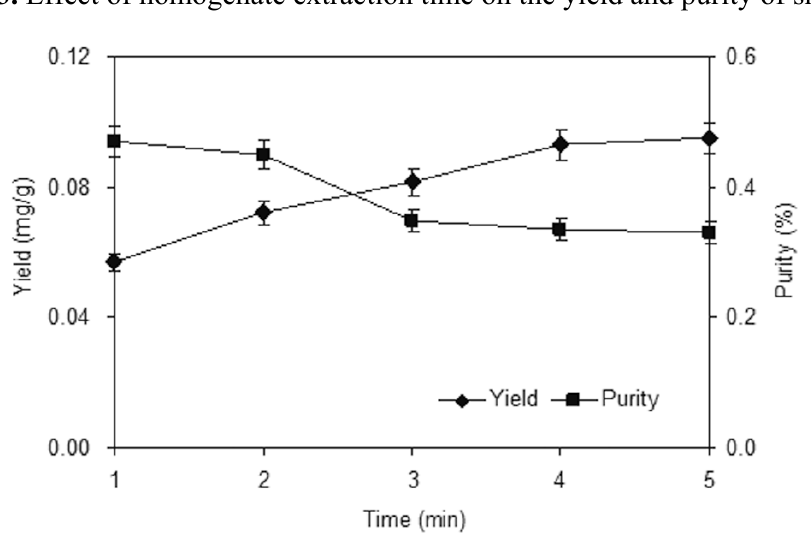
Figure 3. Effect of homogenate extraction time on the yield and purity of